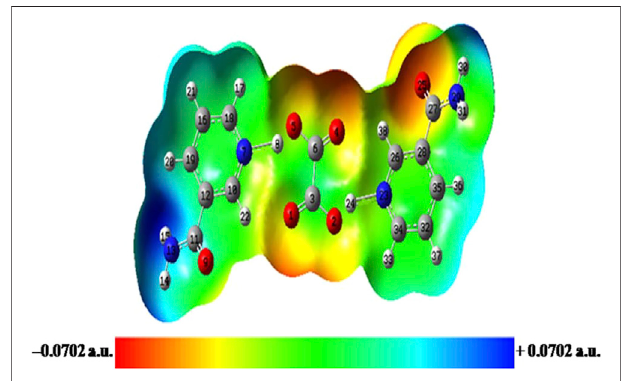
FIGURE 6 | Molecular electrostatic potential (MESP) map of NIC – OXA salt formed by mapping of total electron density over electrostatic potential in the gas phase. NIC – OXA, nicotinamide – oxalic